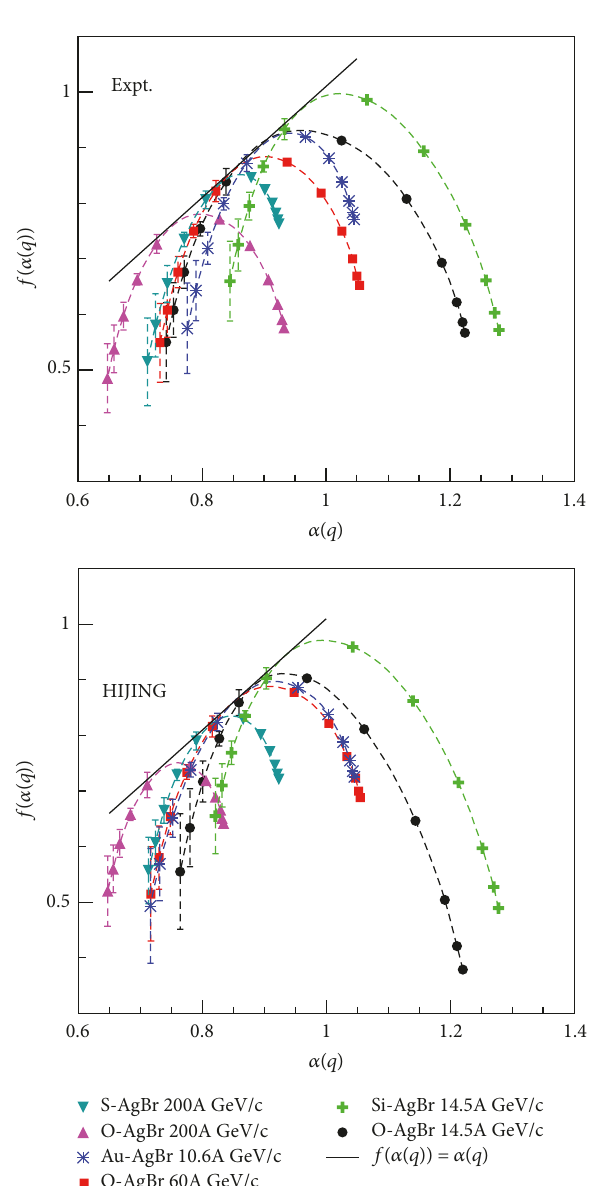
Figure 6: 𝑓(𝛼(𝑞)) spectra for the experimental and HIJING event